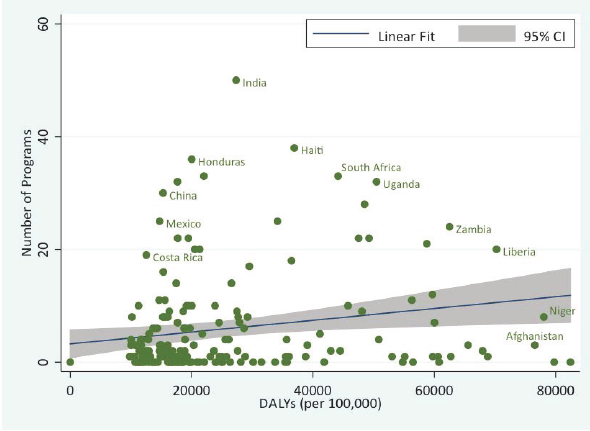
Figure 2. Intensity of programmatic activity by country–level burden of disease. Points above the fitted line represent countries that have a greater number of programs than predicted by our regression model, whereas points below the line represent countries that have fewer programs than